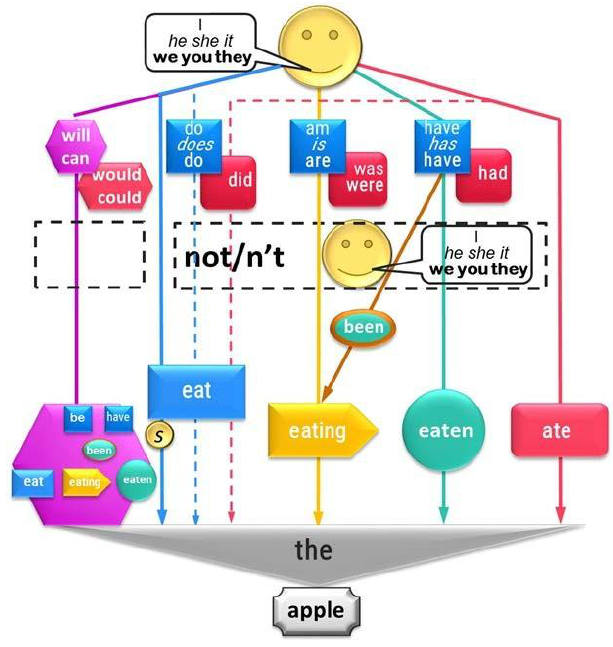
Fig. 1. Full model of all active Levels.